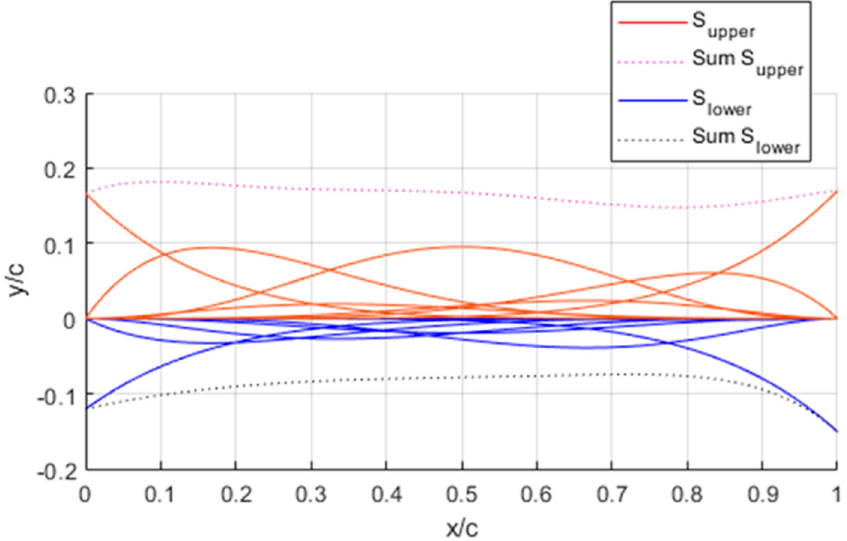
= 0 , and 𝑦 (cid:3039)(cid:3042)(cid:3050)(cid:3032)(cid:3045) (cid:3261)(cid:3254) (cid:3261)(cid:3254)